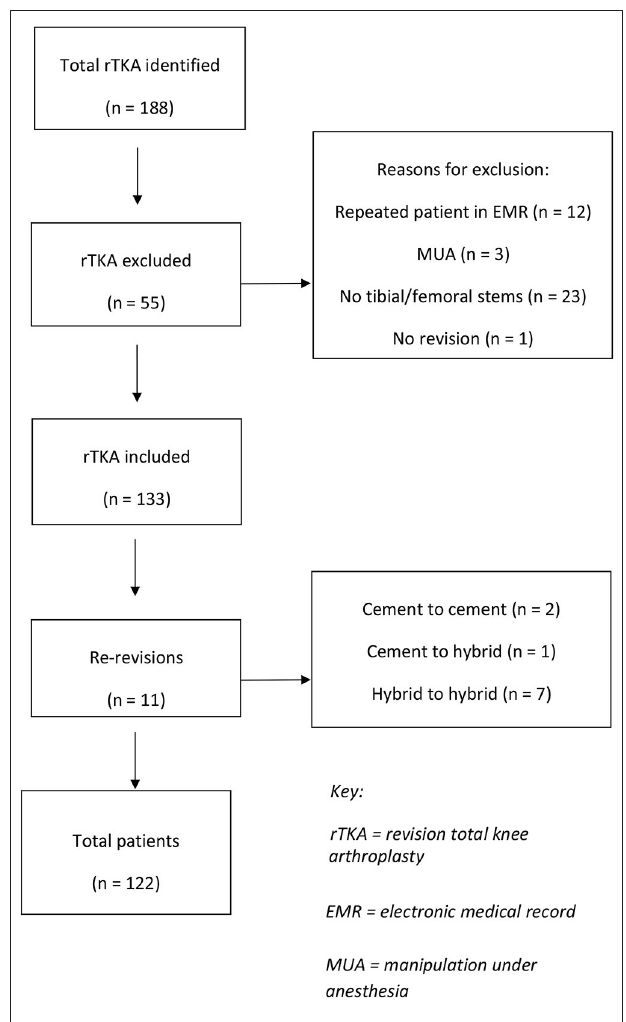
FIGURE 2 | rTKA flow